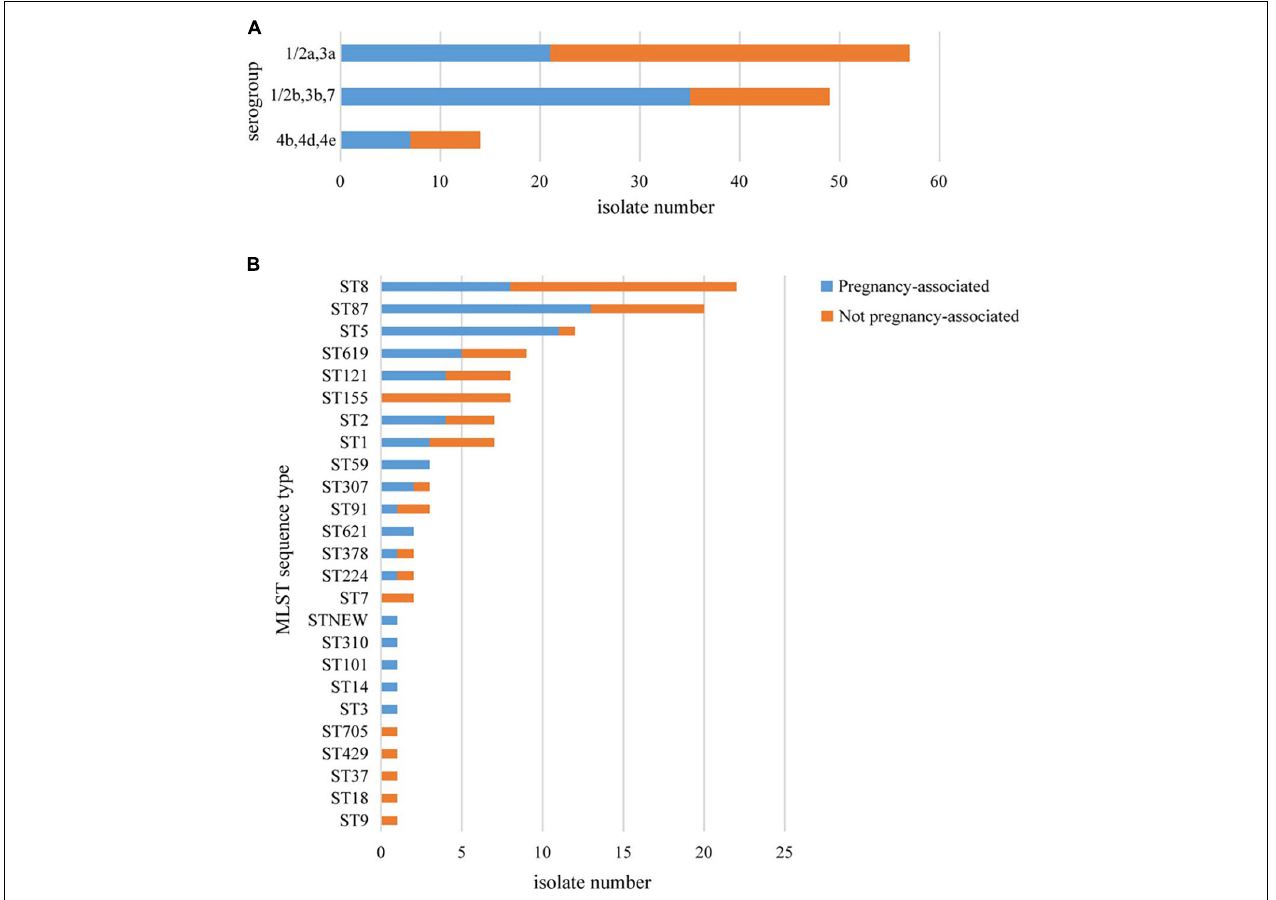
FIGURE 1 | Basic epidemiological characteristics of 120 L. monocytogenes isolates isolated from 120 cases in this study. The distribution of isolates is shown according to their molecular serogroup (A) and their MLST sequence type (B)